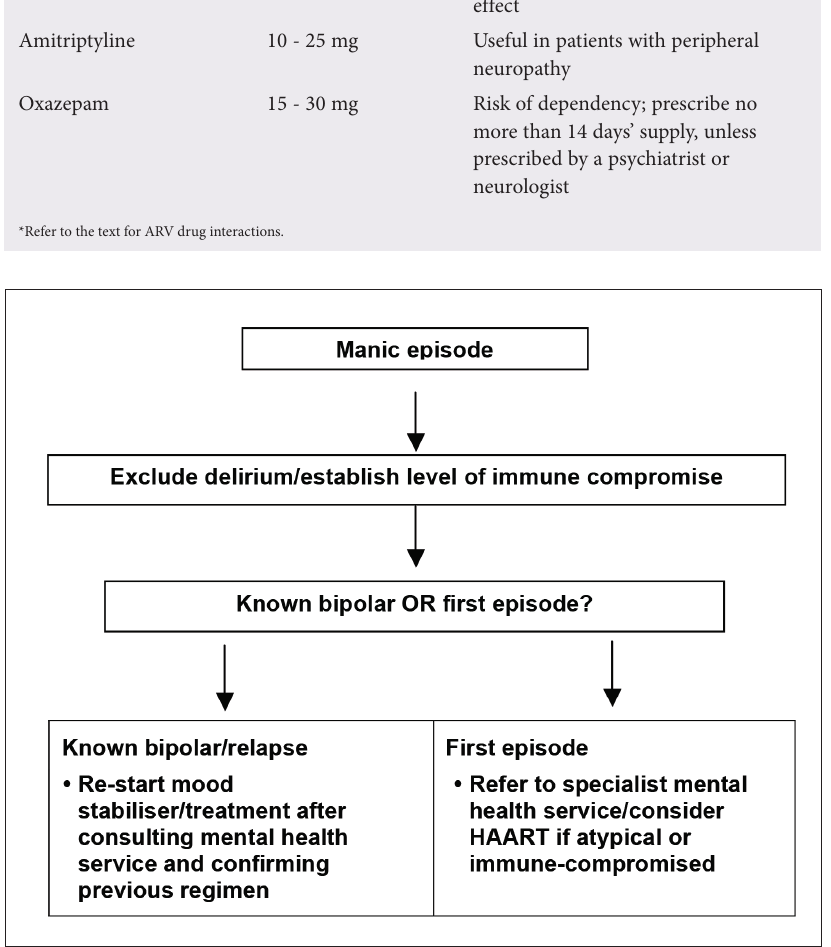
Fig. 2. An approach to the HIV-infected patient with mania. HAART = highly active antiretroviral